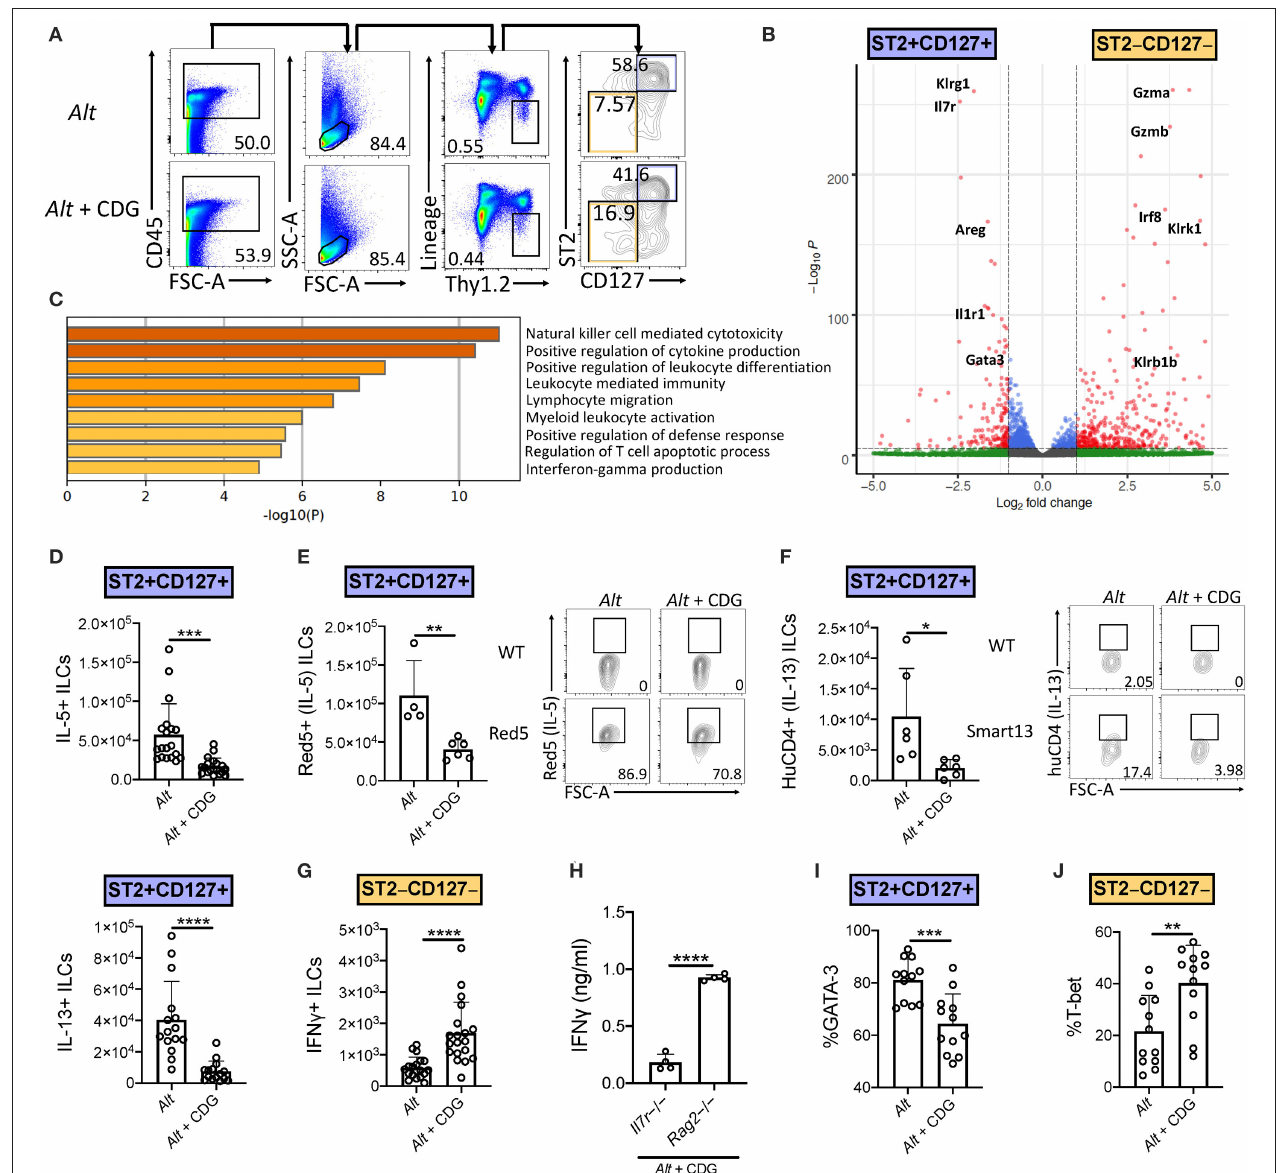
FIGURE 2 | CDG induces ILC2 to ILC1 compartmental changes. Mice were challenged using the same model as in Figure 1A . (A) Flow cytometric gating scheme for identification of lung ILC2s and ILC1s in Alt and Alt plus CDG challenged mice. (B) RNAseq volcano plot of differentially expressed genes between Alt challenged lung ST2 + CD127 + ILCs and ST2–CD127– ILCs. (C) Differentially expressed gene ontology pathways in ST2 + CD127 + and ST2–CD127– ILC subpopulations. (D) Total number of IL-5 + (top) and IL-13 + (bottom) lung ILC2s following PMA/ionomycin stimulation ex vivo . (E) Total number of Red5 + (IL-5 + ) lung ILC2s (left) and representative flow plots (right). (F) Total number of HuCD4 + (IL-13 + ) lung ILC2s (left) and representative flow plots (right). (G) Total number of IFN γ + lung ILC1s following PMA/ionomycin stimulation ex vivo . (H) Il7r -/- and Rag2 -/- BAL IFN γ ELISA. Frequency of GATA-3 + lung ILC2s (I) and T-bet + lung ILC1s (J) . Data shown are representative of 2–7 independent experiments with 2–4 mice per group. * P < 0.05, ** P < 0.01, *** P < 0.001, **** P < 0.0001, unpaired t